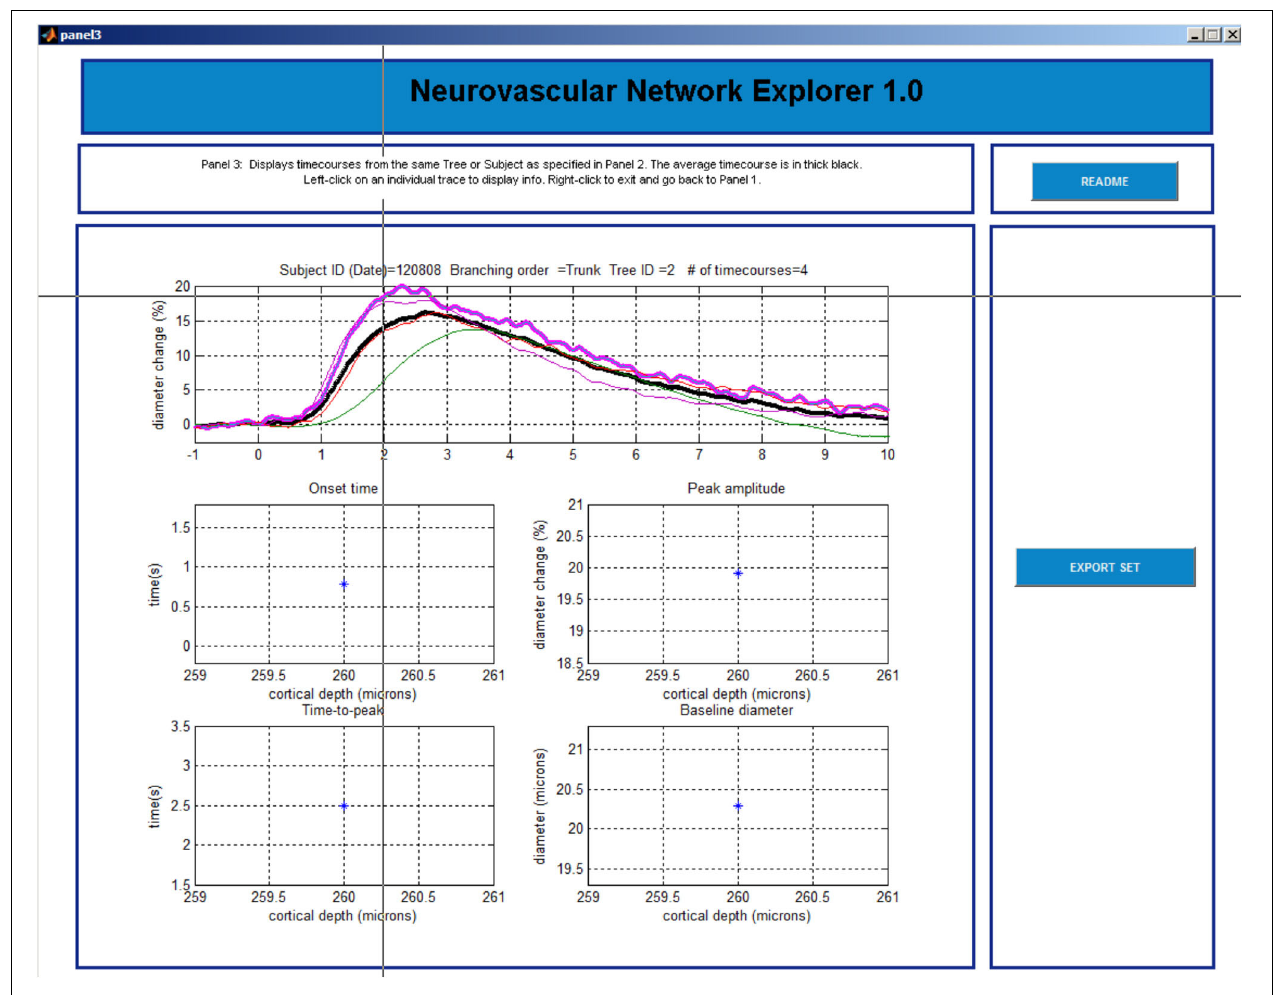
FIGURE 5 | GUI, panel